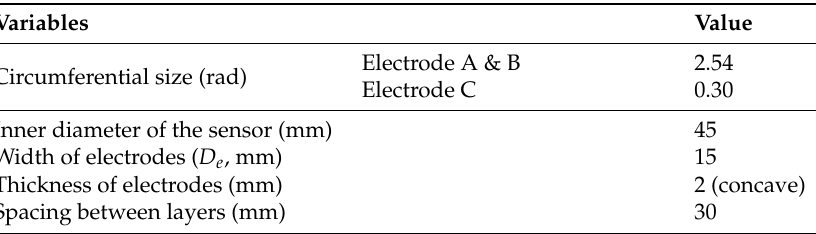
Table 2. Details of the optimized sensor configurations.